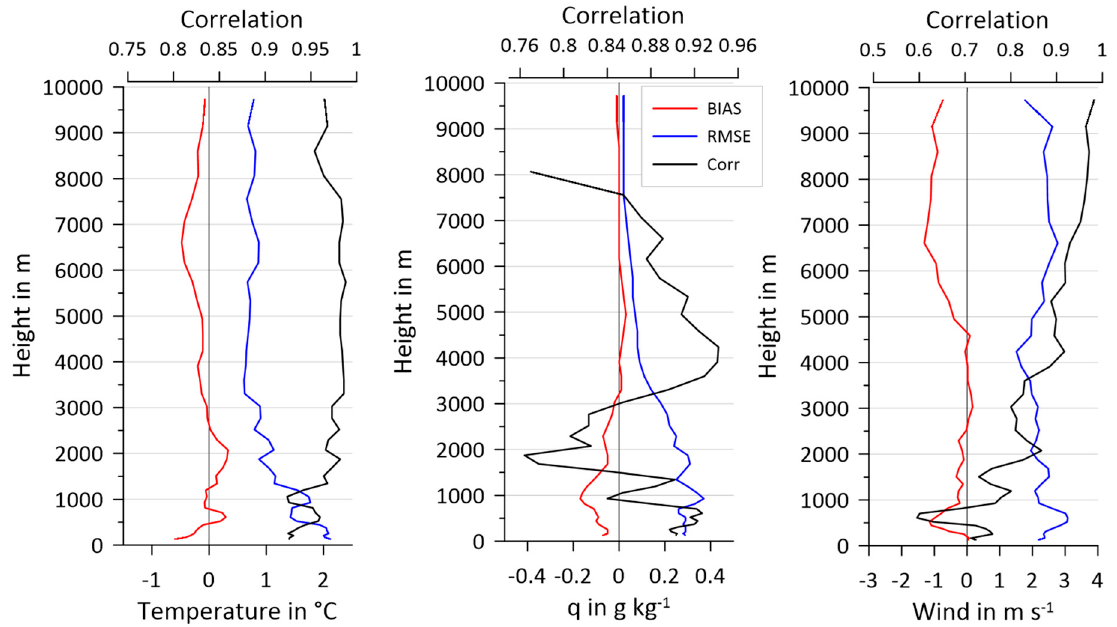
Figure 11. Profiles of bias, RMSE and correlation for the comparison of CCLM with radiosondes for temperature ( left ), specific humidity ( middle ) and wind speed ( right ) for 1–29 April 2019 (54 profiles).